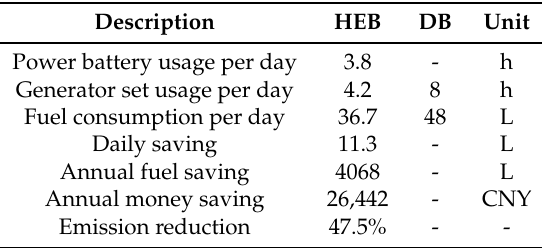
Table 7. Comparison of power consumption of a HEB and DB in variable-speed navigation. DB: diesel propulsion boat.